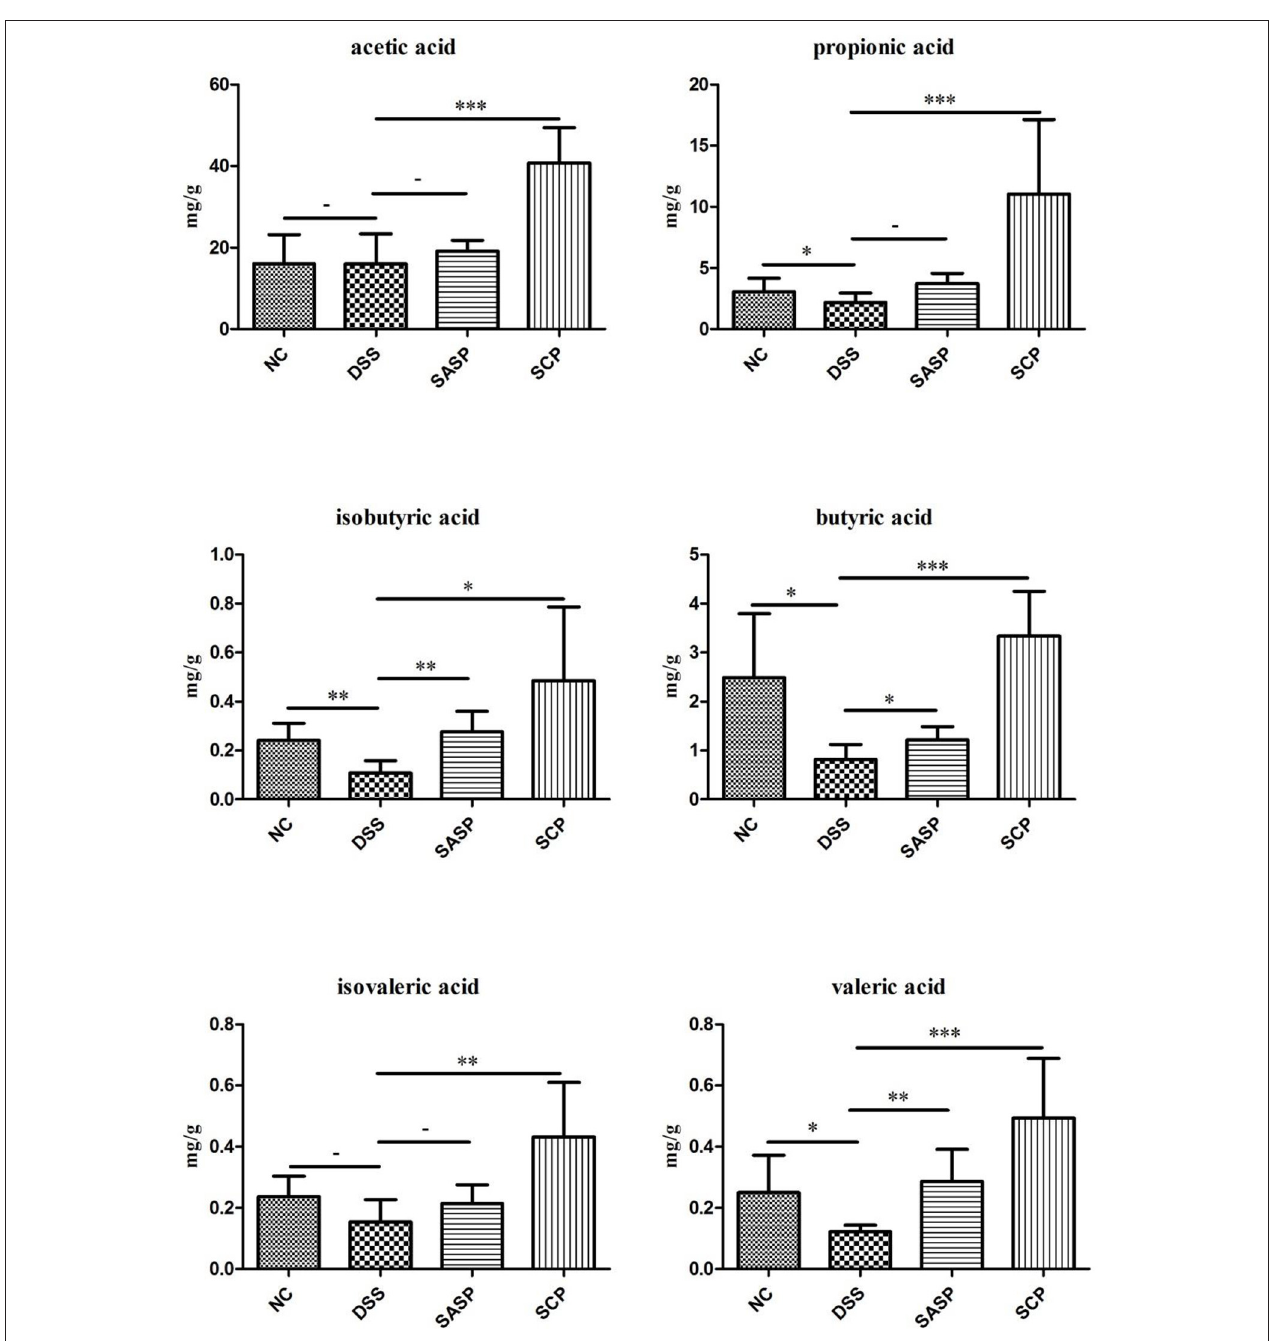
FIGURE 9 | Concentrations of SCFAs in mice colonic contents. NC, control group; M, DSS group; SASP, positive drug group; SCP, S. chinensis polysaccharide group. Data are expressed as means ± S.D. * 0.01 < p ≤ 0.05, ** 0.001 < p ≤ 0.01, *** p ≤ 0.001.